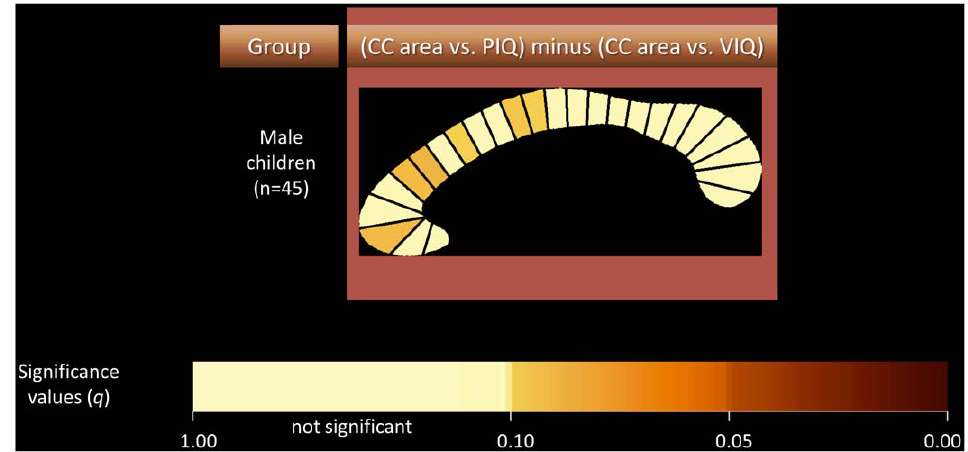
Figure 6. Direct comparison of VIQ and PIQ correlations in male children.